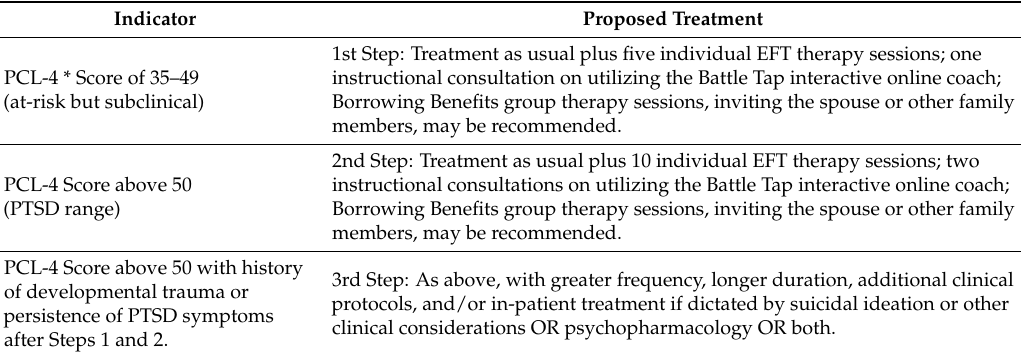
Table 1. Clinical Guidelines for treating post-traumatic stress disorder (PTSD) with Emotion Freedom Techniques (EFT).